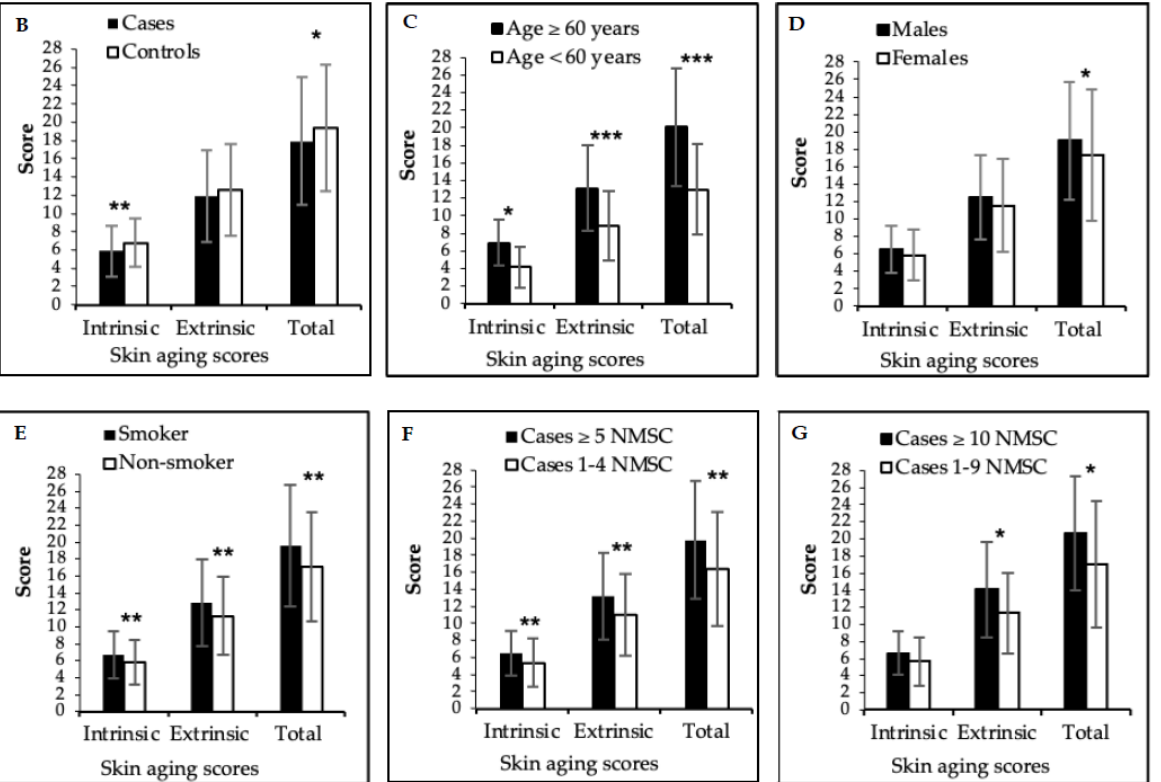
Figure 2. Signs of skin aging and skin aging scores. Significant p values are indicated by asterisks: * p < 0.05, ** p < 0.01, *** p < 0.001. ( A ) Signs of skin aging in cases and controls; ( B ) skin aging scores (mean ± standard deviation) in cases and controls; ( C ) in age groups ≥60 ( n = 310) and <60 ( n = 78) years at time of evaluation; ( D ) in males ( n = 298) and females ( n = 90); ( E ) correlated with smoking history: smokers ( n = 243) and non-smokers ( n = 145); ( F ) in cases with ≥5 NMSC s ( n = 87) and cases with 1 – 4 NMSCs ( n = 107); ( G ) in cases with ≥10 NMSC s ( n = 44) and cases with 1 – 9 NMSCs ( n = 150).